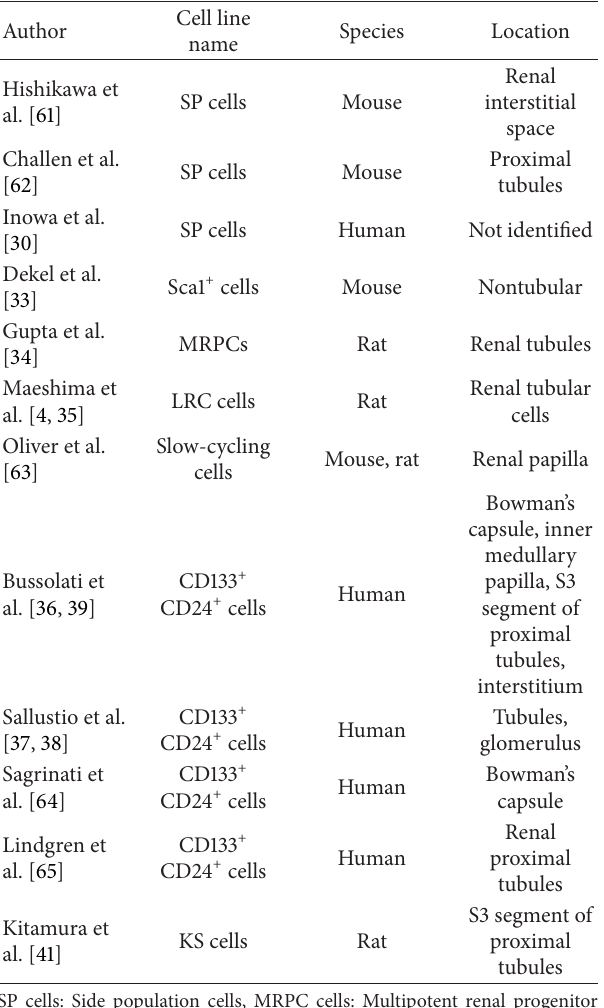
Table 1: The summary of trophic effect of secreted factors from tissue stem cells.